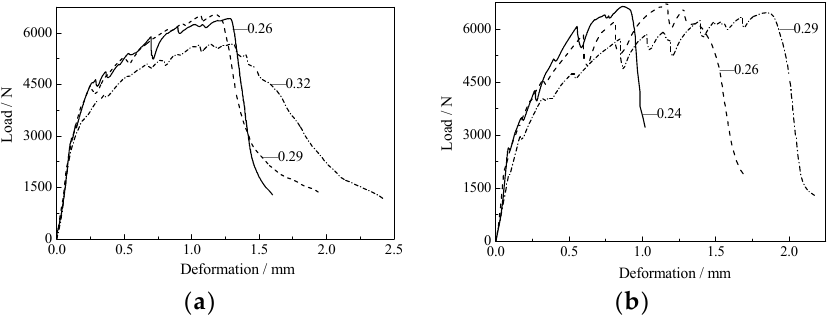
Figure 8. Effect of the water–binder ratio of HDC on load-deflection curves: ( a ) 56 d; ( b ) 28 d.